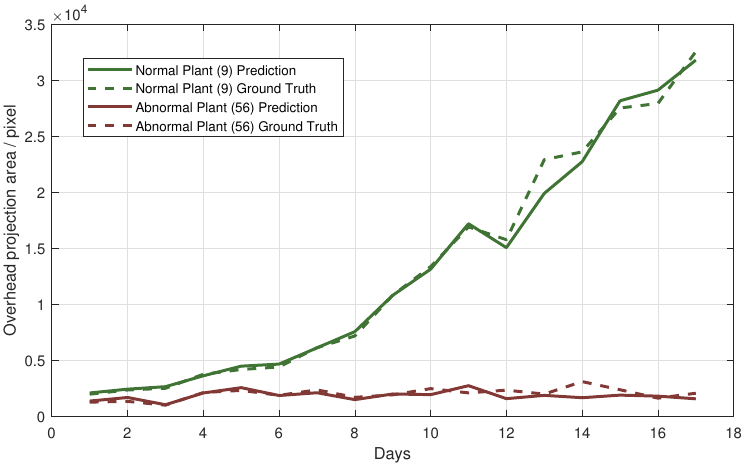
Figure 9. Top-view projected area curves of two leafy greens during their